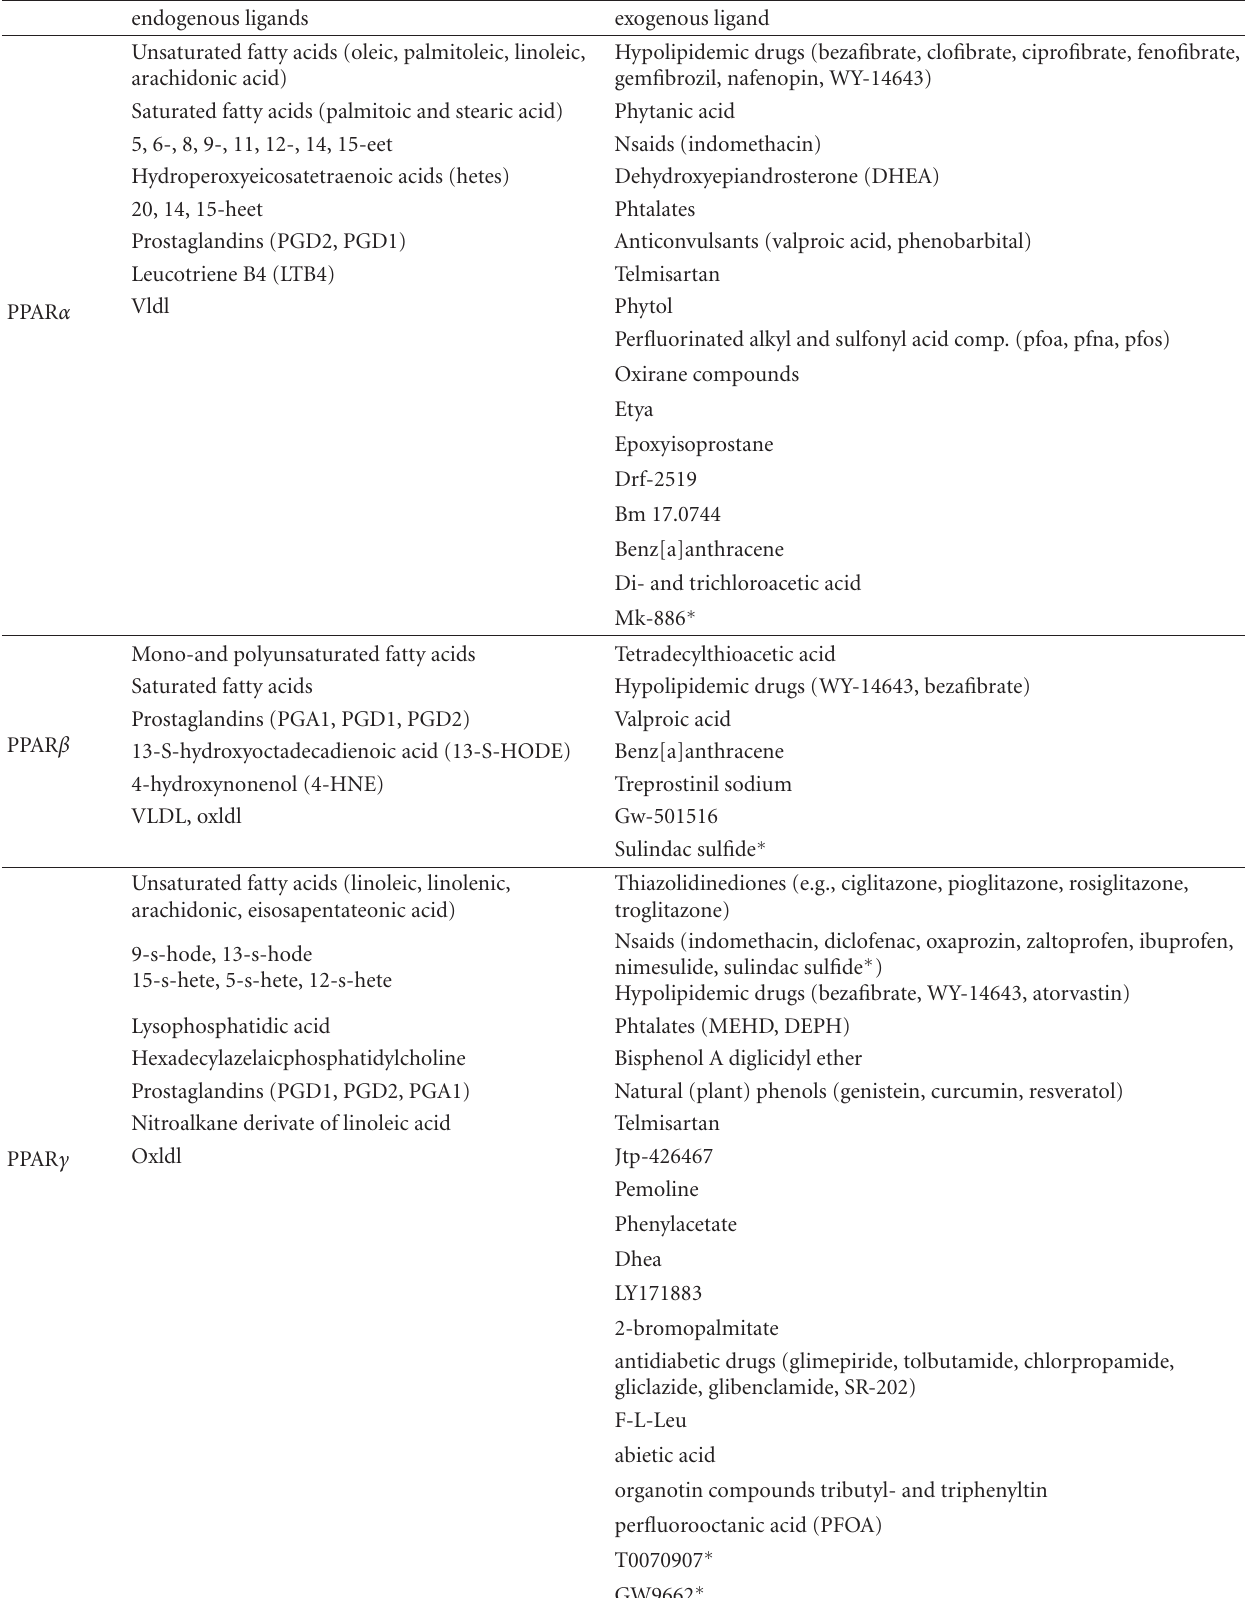
Table 3: Overview of PPARs endogenous and exogenous ligands according to